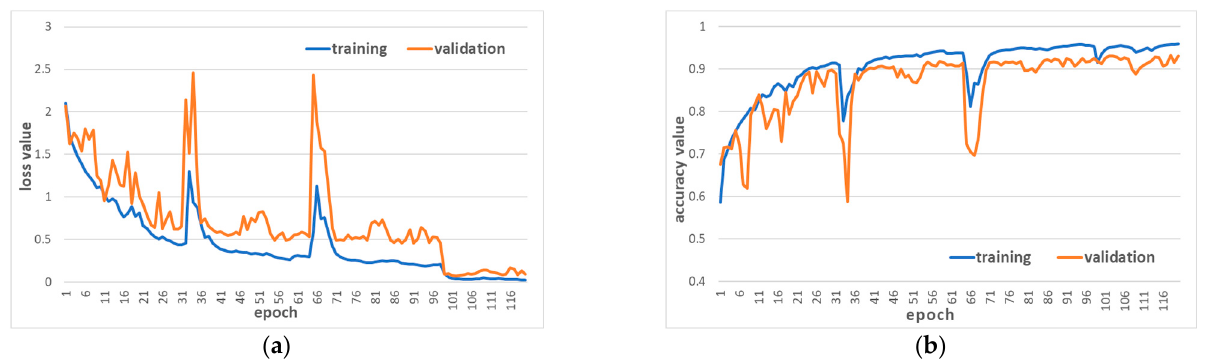
Figure 12. Training process for Hainan dataset B. ( a ) Loss curve. ( b ) Accuracy curve.